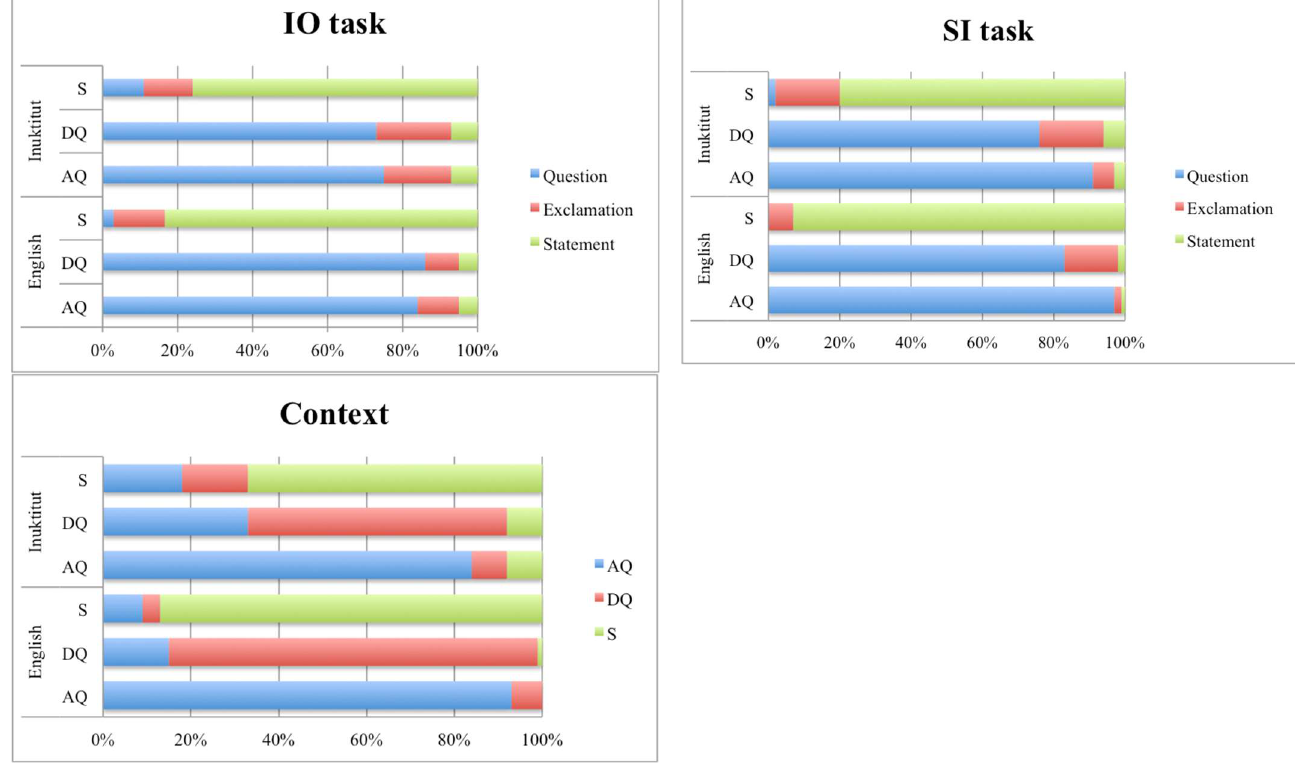
Figure 3. Proportion of response type by Task (IO = Intonation only; SI = segments and intonation; C = Contextualized) and Sentence Type. Results are organized by language group.